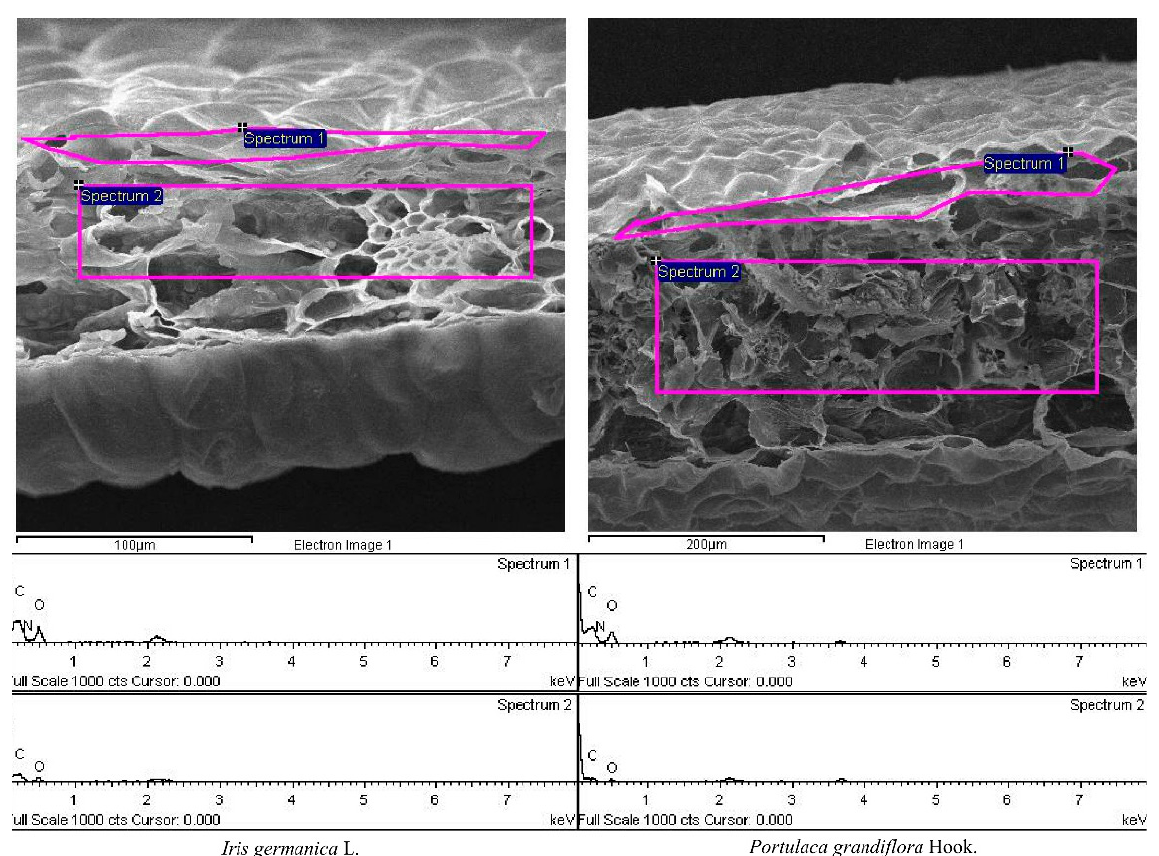
Figure 2. Example of field emission scanning electron microscope output for the leaves of two species. Spectrum 1 and 2 are the sample area for the weight percentage (%) of carbon (C), nitrogen (N), and oxygen (O) in the upper epidermis and mesophyll tissue of leaves, respectively.